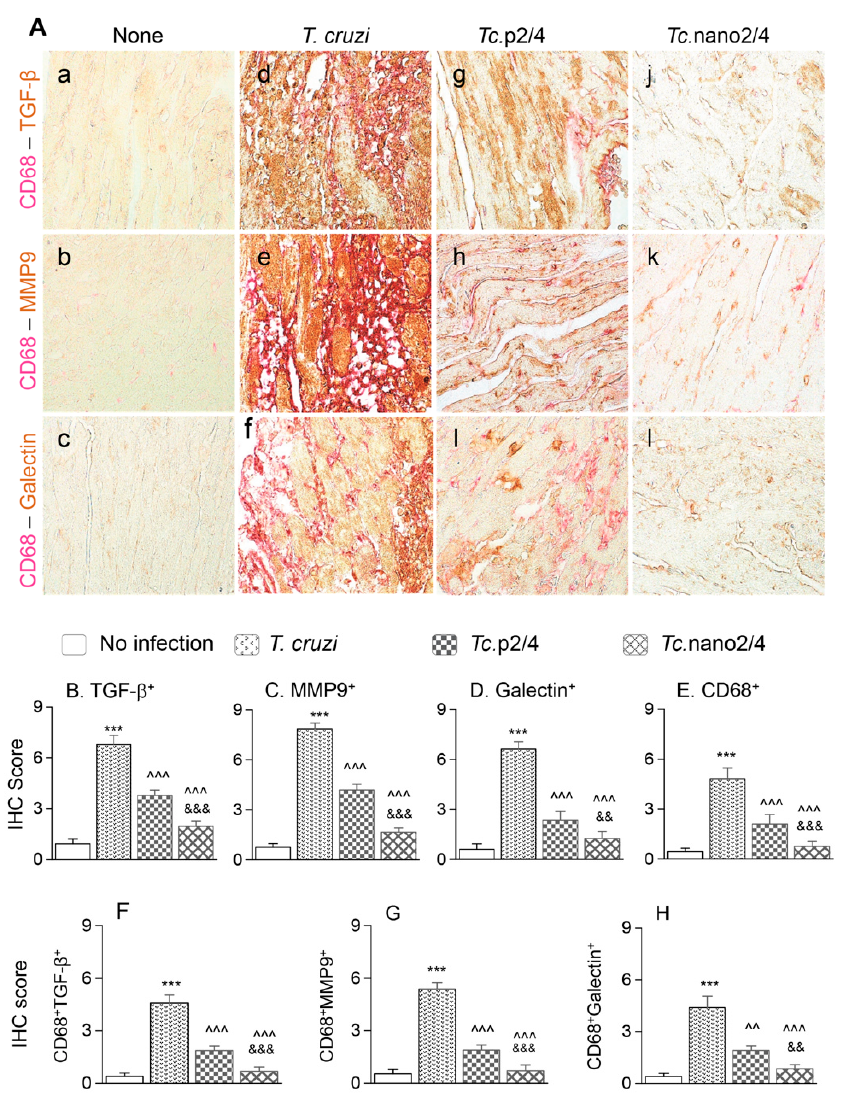
Figure 6. Nano2 / 4-immunotherapy controlled tissue fibrosis through modulation of macrophages in Chagas disease. Mice were infected, treated, and euthanized in chronic phase. Paraffin-embedded 5 µ m heart tissue sections were subjected to immunohistochemical (IHC) staining. ( A ) Shown are representative images of heart tissue from non-infected (panels (a–c)), T. cruzi -infected (panels (d–f)), Tc. p2 / 4 (panels (g–i)), and Tc. nano2 / 4 (panels (j–l)) groups of mice (60 × magnification). Tissues were stained for CD68 (macrophage marker) along with TGF- β (a,d,g,j), MMP9 (b,e,h,k), and galectin-3 (c,f,i,l). ( B – H ) Semi-quantitative IHC scores for TGF- β ( B ), MMP9 ( C ), galectin-3 ( D ), and CD68 ( E ) are presented. Co-localization of CD68 with TGF- β ( F ), MMP9 ( G ) and galectin-3 ( H ) was scored as described in the Materials and Methods section. IHC score values are presented as mean ± SD ( n = 3 mice per group, 2 tissue sections per mouse, 9 microscopic fields per tissue section, analyzed at 20 × magnification). Significance was calculated and annotated as described in Figure